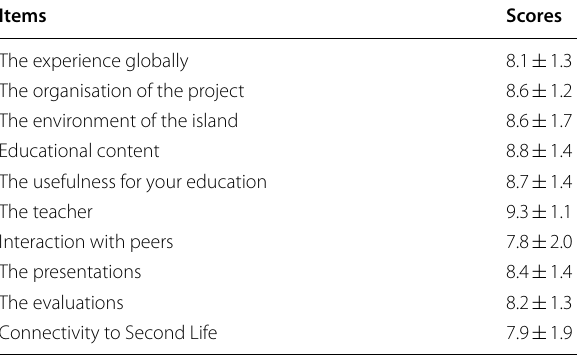
The results represent the mean and standard deviation of 35 questionnaires for each item on a scale of 1 to 10